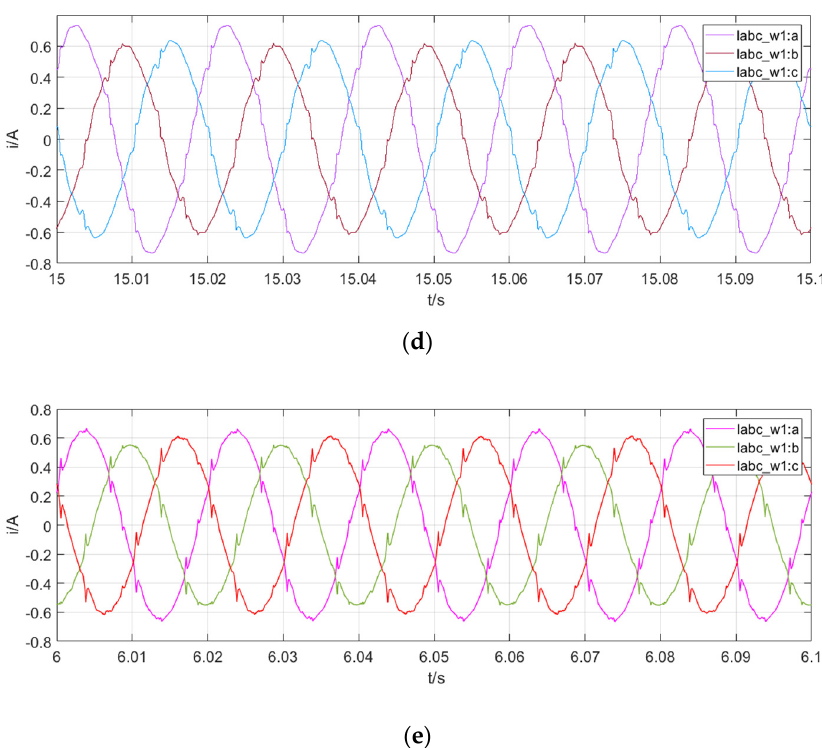
Figure 12. Current waveform of the transformer’s grid-side winding under different operating scenarios. ( a ) Dynamic current responses without any filtering device. ( b ) Dynamic current responses of the inductive filtering (IF) method considering the 5th and 7th fully tuned branches. ( c ) Dynamic current responses of the inductive filtering (IF) method considering the 5th, 7th, 11th, and 13th filters. ( d ) Dynamic current responses of the inductive filtering (IF) method considering the 3rd, 5th, 7th, 9th, 11th, and 13th filters. ( e ) Dynamic current responses under the proposed HIAF system.